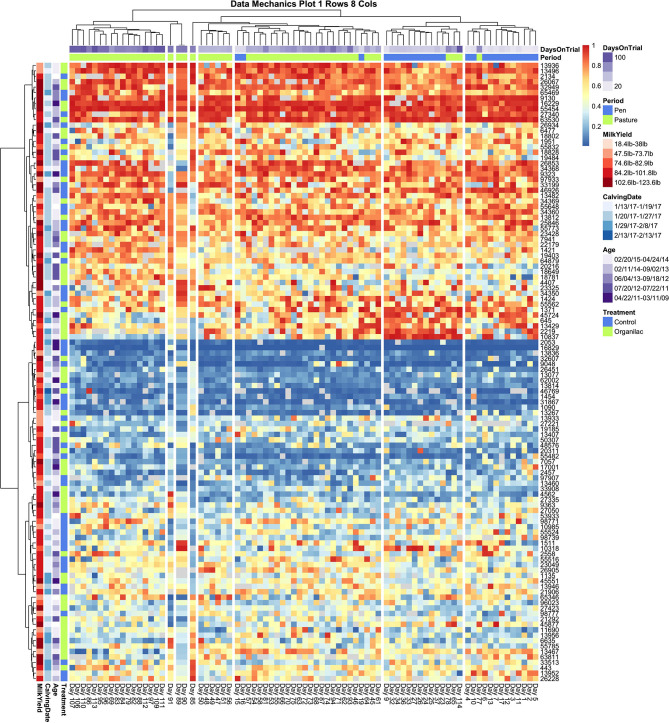
Data Mechanics visualization of cows with no recorded health events. Clustering along the temporal axis has isolated 4 days of milk order observations in middle of the pasture subperiod with anomalous queuing patterns, which can be viewed as irregularities in color values scanning from left to right. These days remain isolated in Data Mechanics mappings which also allow for social stratification along the row axis (see Supplemental Materials), suggesting that these observations likely constitute outliers. Color annotations along the column axis reveal observations from the pen and pasture subperiods remain fairly distinct. No clear patterns or gradients are seen on the row color annotations for cow attributes, even though the heat map itself clearly reflects a gradient along the column axis driven by individual differences in queue entry position. Progressive clustering of the row axis did not bring any additional patterns in cow attribute variables into clear resolution.